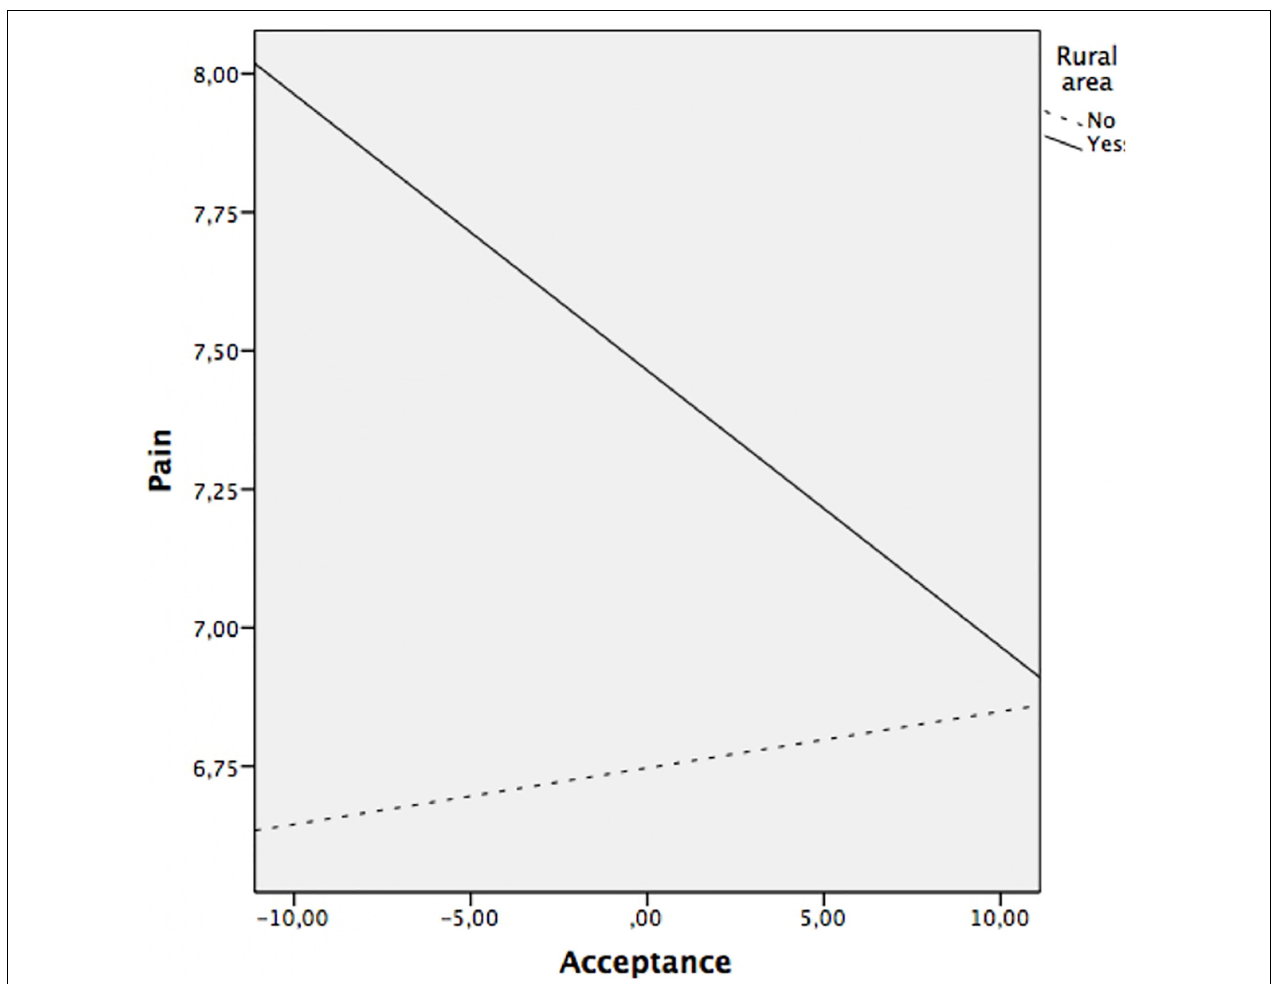
FIGURE 1 | Relationship between acceptance and pain at rural area